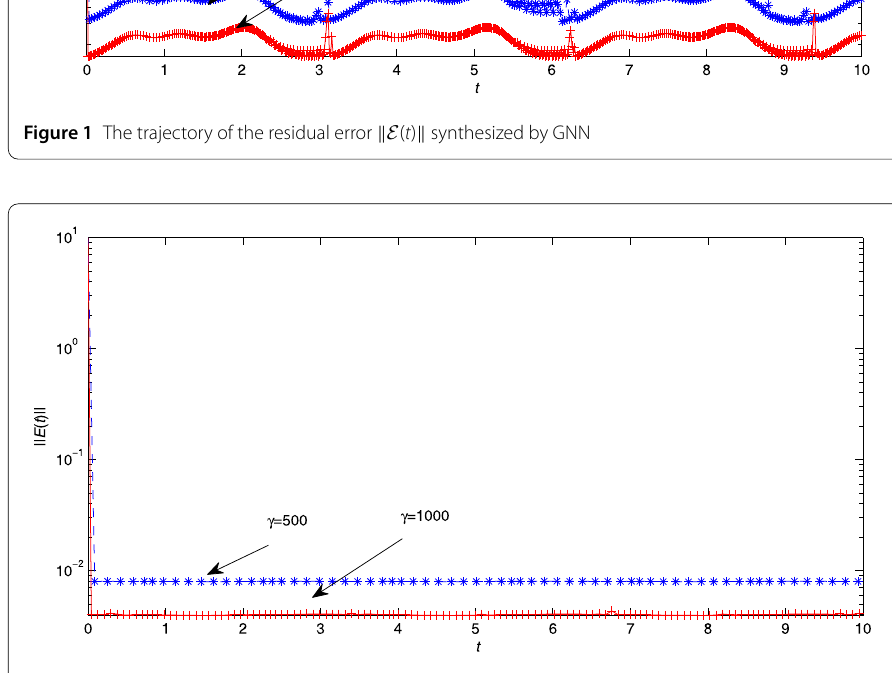
Figure 2 The trajectory of the residual error (cid:9) E ( t ) (cid:9) synthesized by NTCTZNN1